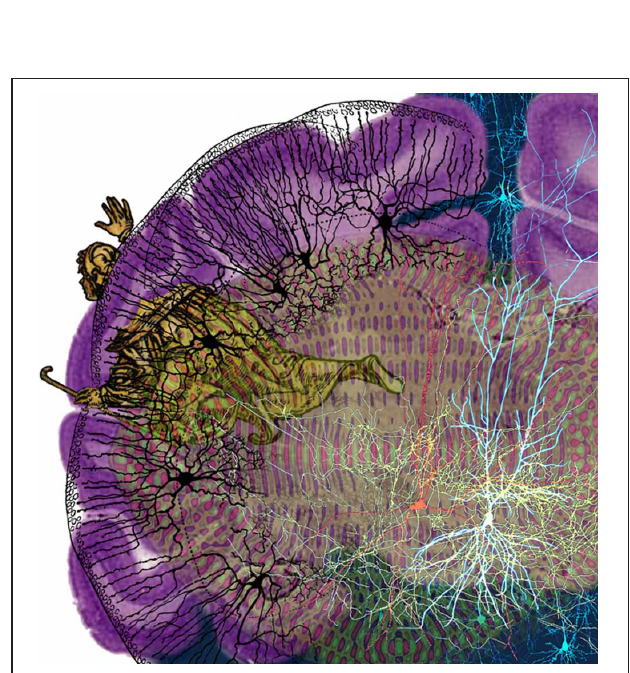
FIGURE 2 | “Resonant Transformations,” a digital collage by the author. The geometric images were created by Eric Heller, using simulations of quantum dynamics and incorporated here to allude to dynamic neural interactions in the brain.